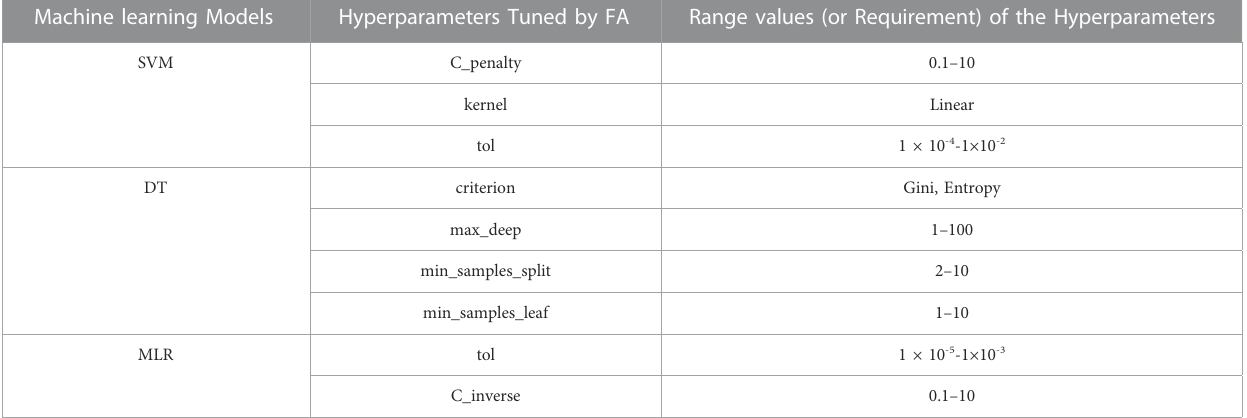
TABLE 3 Hyperparameters of the machine learning models tuned by